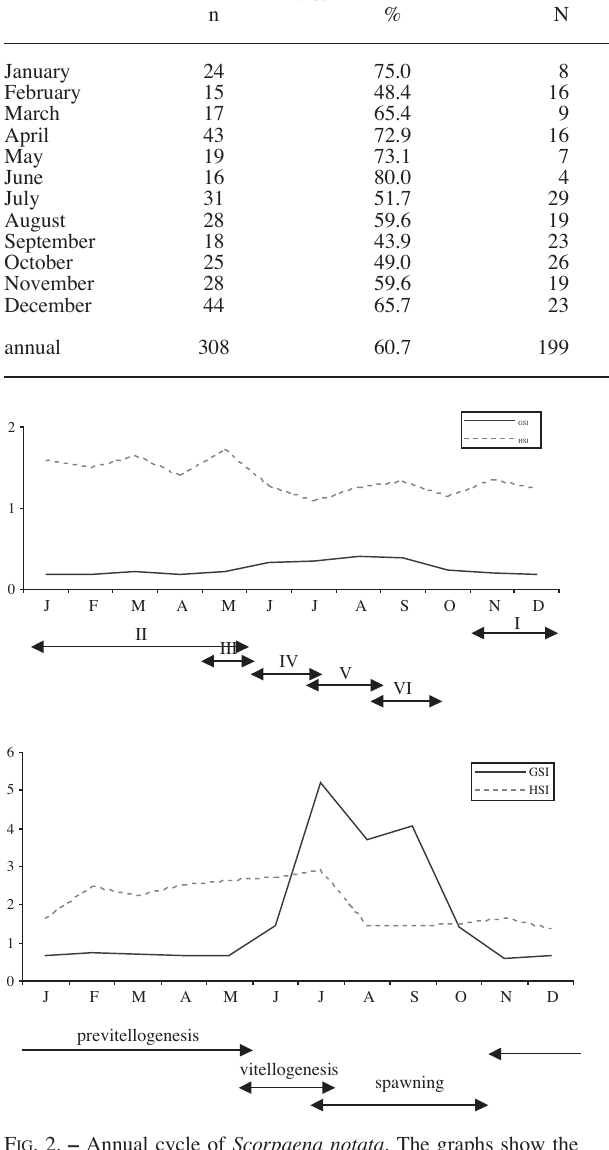
F IG . 2. – Annual cycle of Scorpaena notata. The graphs show the annual development of the indices related to reproduction. Below each graph are details of the stage which the gonads are going through. The testes have the following stages: (I)